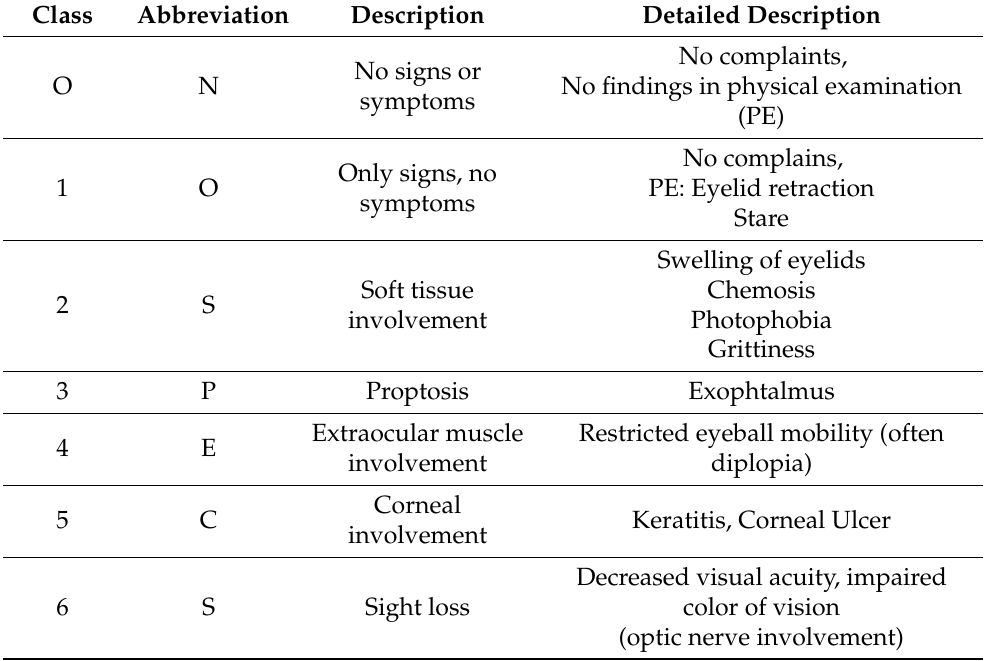
Table 3. This is a table. NO-SPECS ((No signs or symptoms; Only signs or symptoms; Soft tis- sue involvement; Proptosis; Extraocular muscle involvement; Corneal Involvement; Sight loss) classification